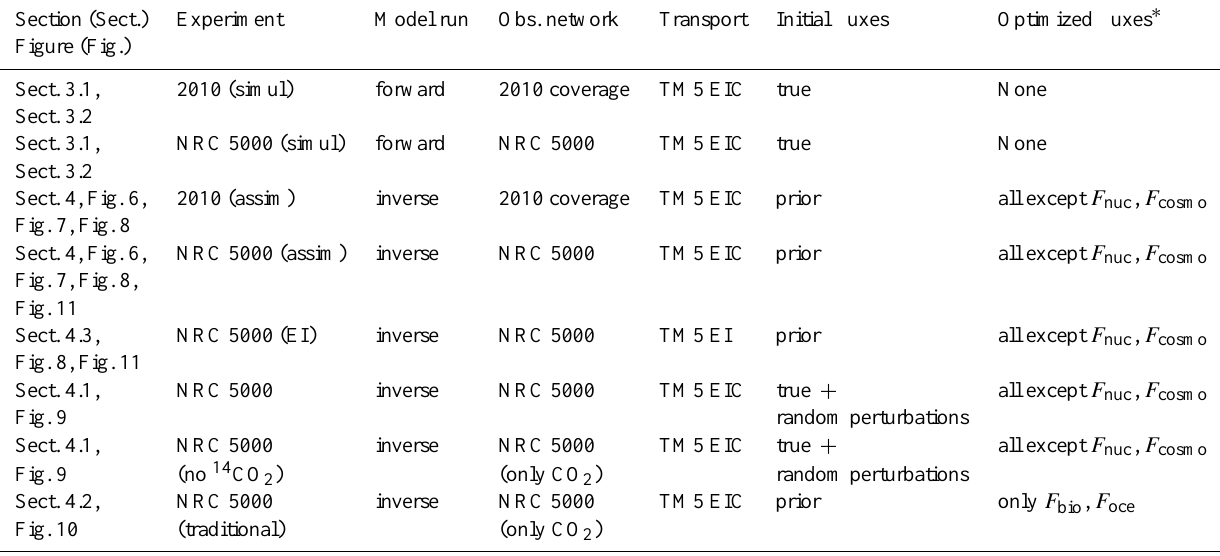
Table 2. Inversions and model runs performed in this work. Section